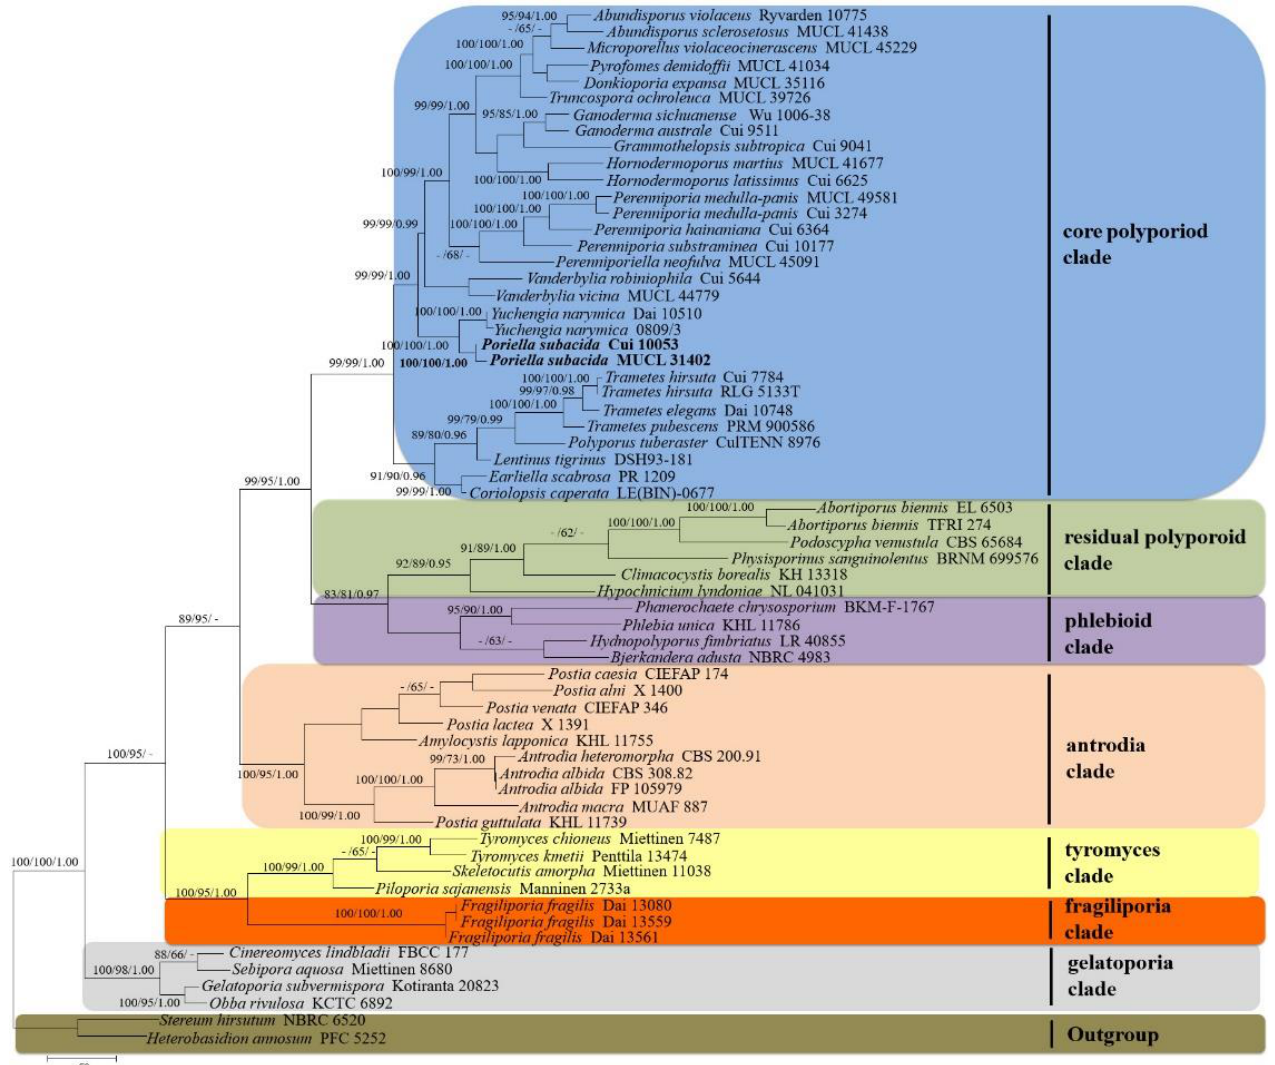
Figure 1. Maximum parsimony strict consensus tree illustrating the phylogeny of Poriella subacida and related species in Polyporales based on ITS+28S sequences. Branches are labeled with maximum likelihood bootstrap higher than 70%, parsimony bootstrap proportions higher than 50% and Bayesian posterior probabilities more than 0.95, respectively. Clade names [ 23 ].